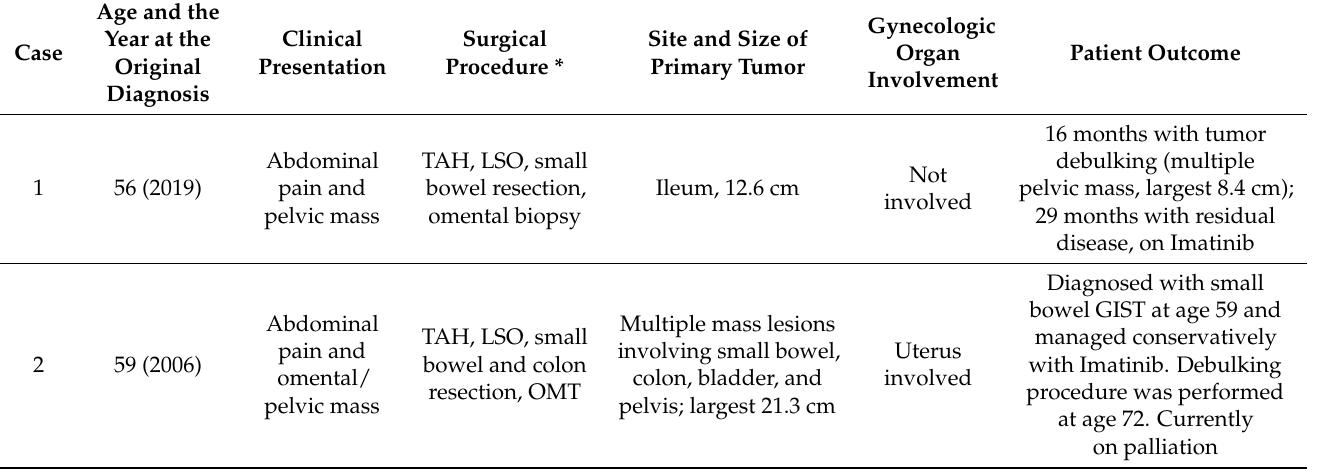
Table 1. Clinicopathological